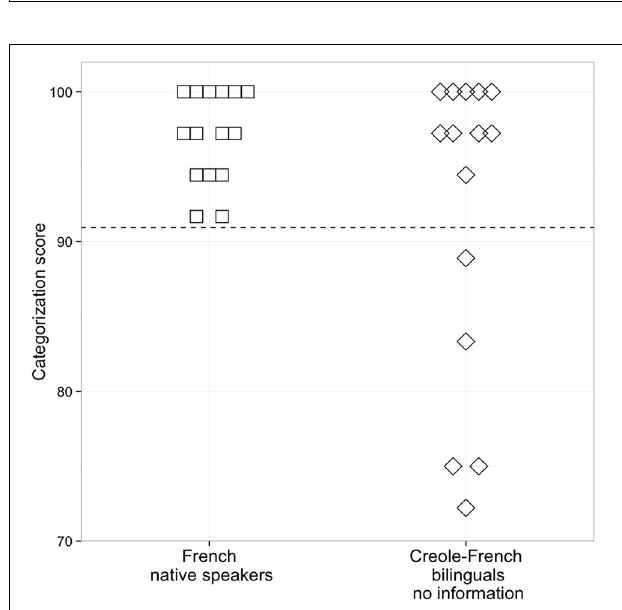
FIGURE 2 | Individual categorization scores (in %) for Native French speakers and Creole-French bilinguals (no-information). The dotted line indicates the native French speakers’ cut-off point (2 standard deviations below the mean categorization